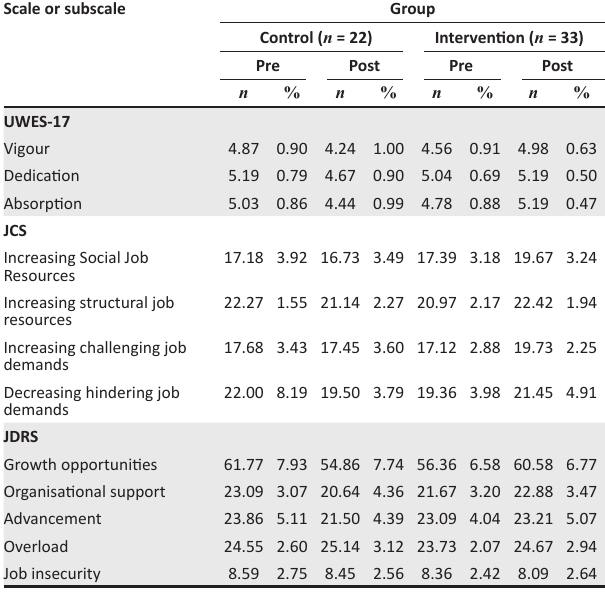
Note: Data are means, with standard deviations in brackets. UWES-17, Utrecht Work Engagement Scale 17-item version; JCS, Job Crafting Scale; JDRS, Job Demands-Resources